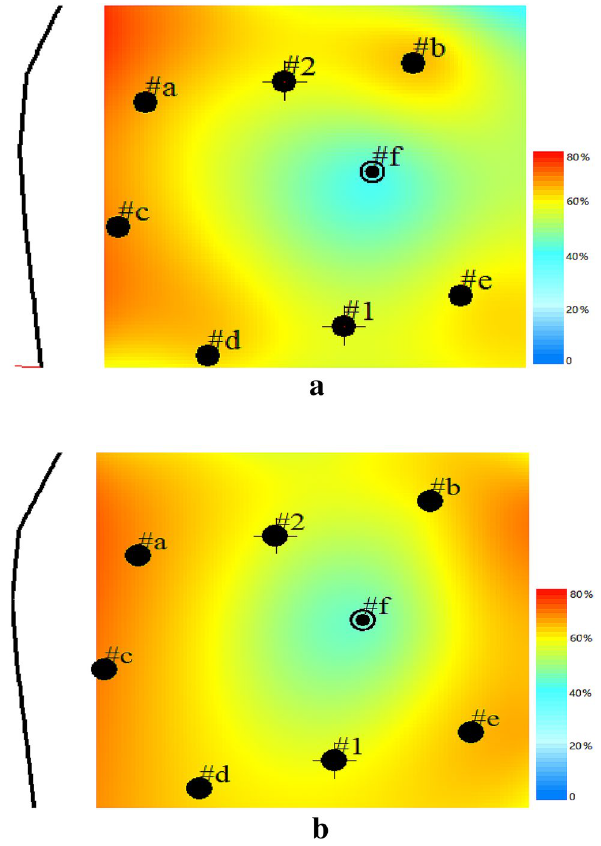
Fig. 7 a Distribution of remaining oil saturation of S22 layer in the injection and production unit, b distribution of remaining oil satura- tion of S26 layer in the injection and production